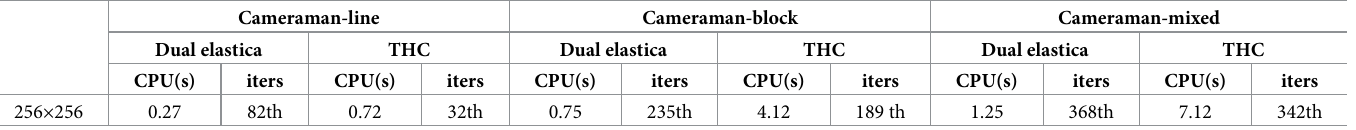
Table 2. The number of iterations to reach convergence (iters) and the total CPU time in seconds (CPU(s)) for different images of different sizes by using our algo- rithm and the THC algorithm in the inpainting